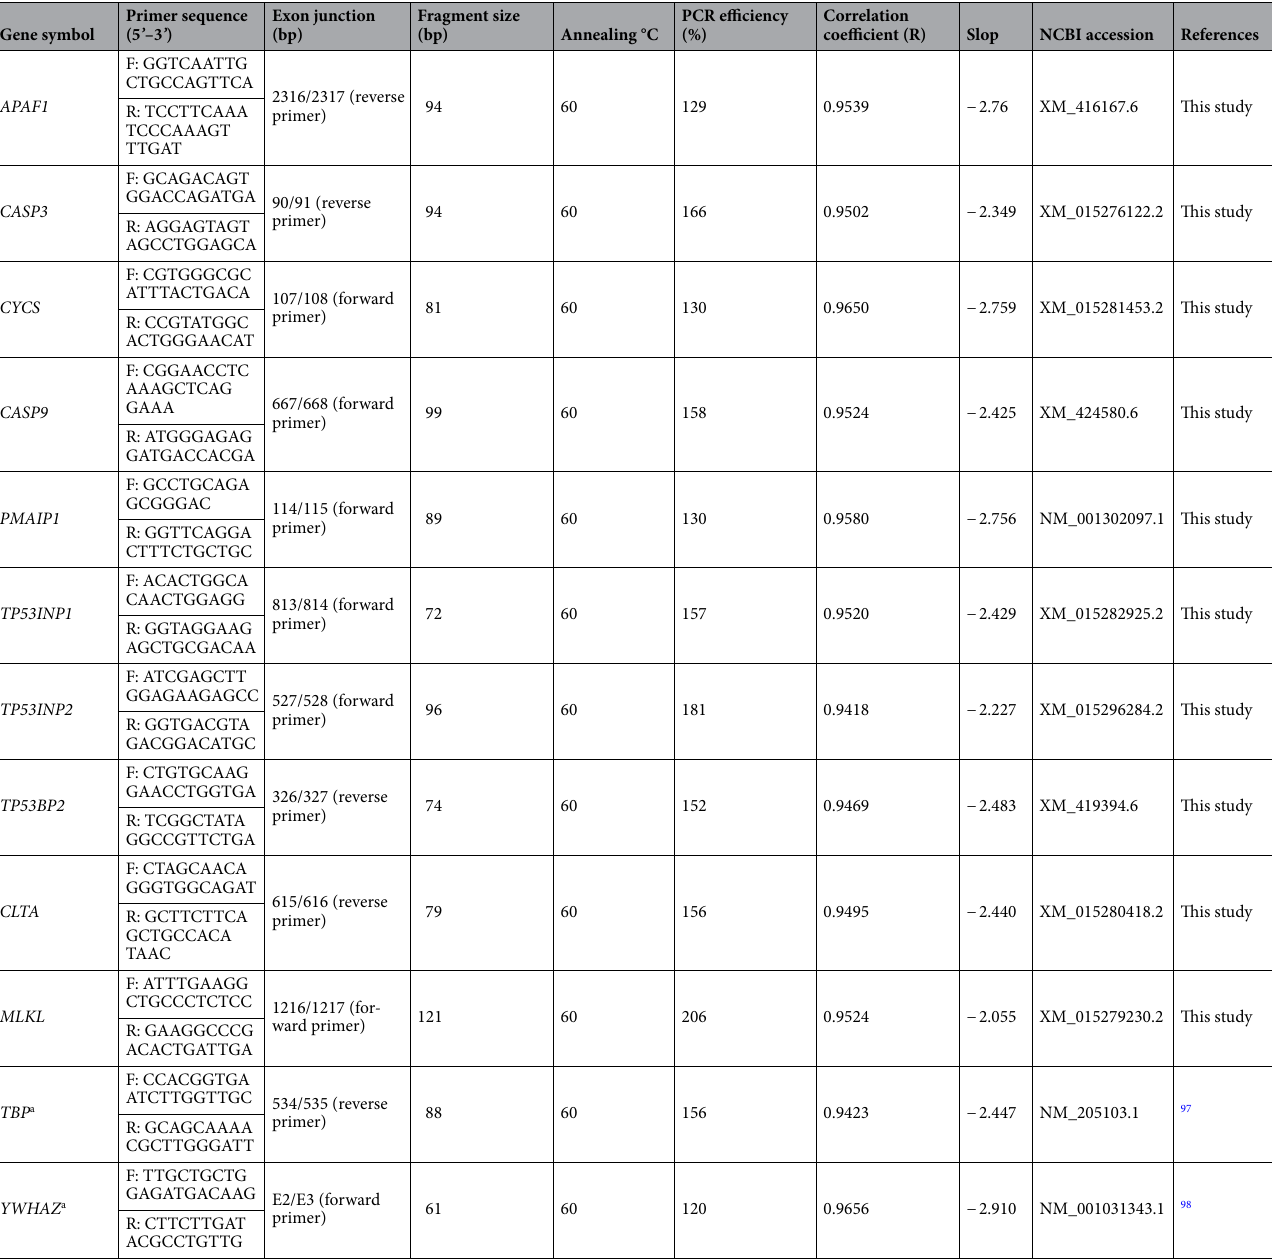
Table 6. Primer sequence used in qPCR for RNA-Seq data validation. For calculating amplification efficiency, a standard curve was generated using a tenfold dilution of cDNA. The standard curve was created by plotting the Cq values against the log of the starting quantity of template for each dilution. a Used as reference genes for relative expression data analysis. Exon junction represent the spanning of exon on genes